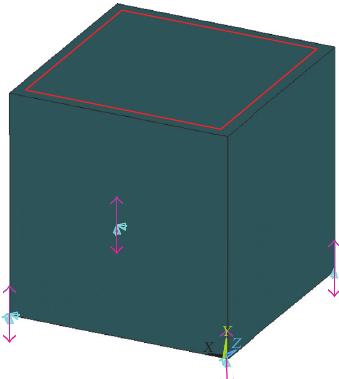
Figure 2: Schematic diagram of the ANSYS